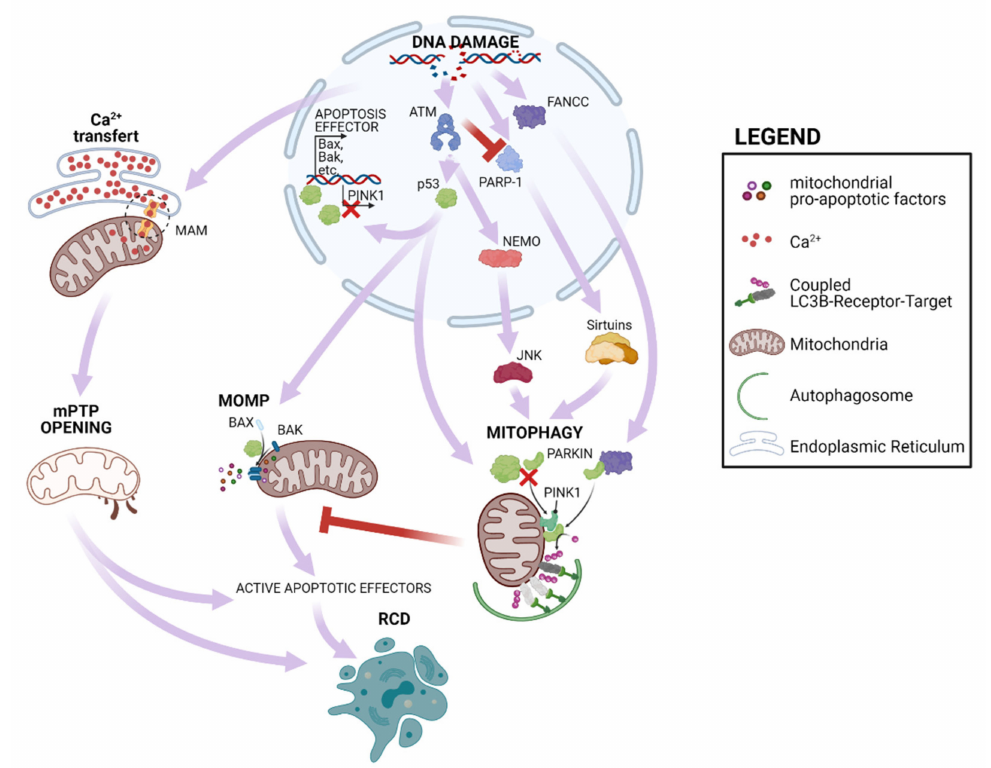
Figure 1. Mitochondrial response to DNA damage. DNA damage can induce RCD by eliciting Ca 2+ transfer from ER to mitochondria which cause mPTP opening and inducing p53 activation. This favors expression of mitochondrial pro- apoptotic factors as well as MOMP engagement. Further DNA damage response can exert both positive and negative regulation of mitophagy which antagonizes